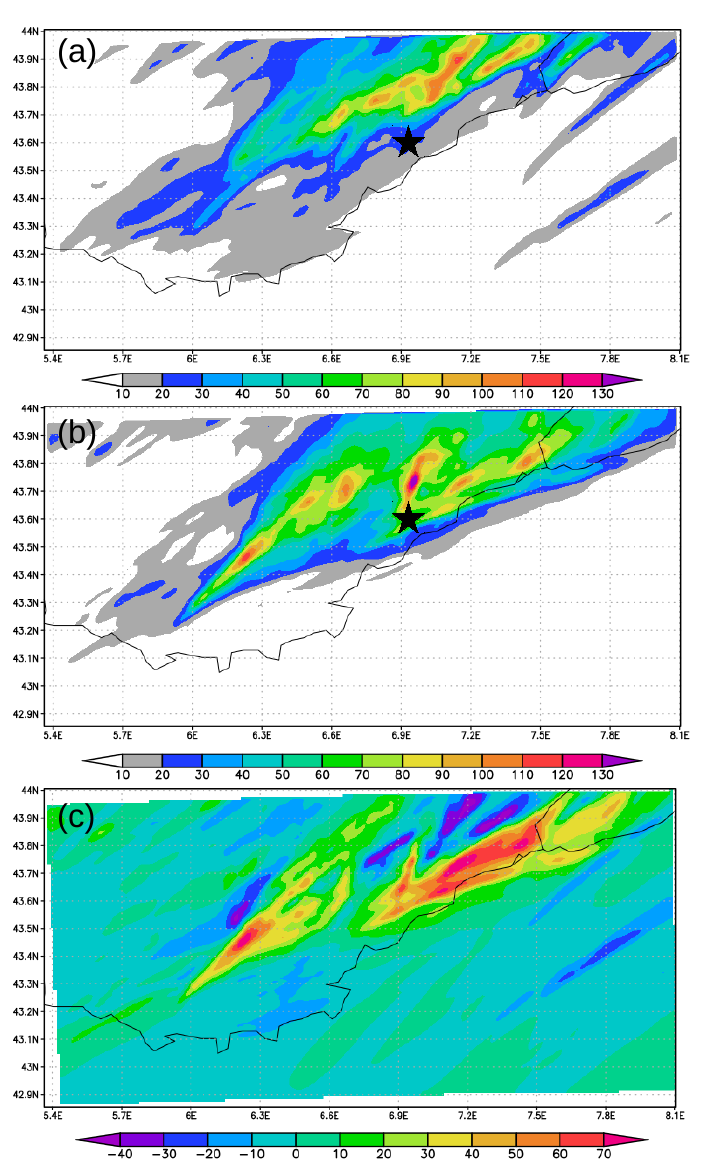
Figure 12. Panel ( a ): the 6 h simulated precipitation (mm) provided by W_GFSANL. Panel ( b ): 6 h simulated precipitation provided by W_GFSANL_SST. Panel ( c ): 6 h cumulated precipitation difference (mm) between W_GFSANL and W_GFSANL_SST. Accumulation period is 17 UTC–23 UTC, 3 October 2015. Black star identifies observed precipitation peak